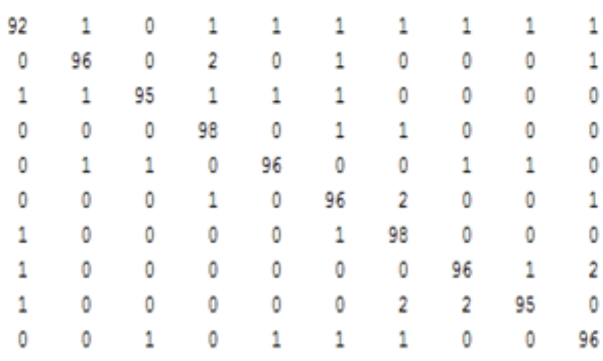
Figure 12. Confusion Matrix obtained for Corel-1K dataset by